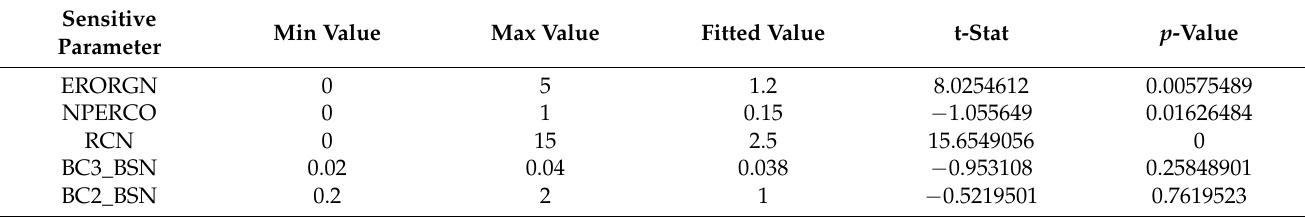
Table 3. Nitrate-sensitive parameters in the study